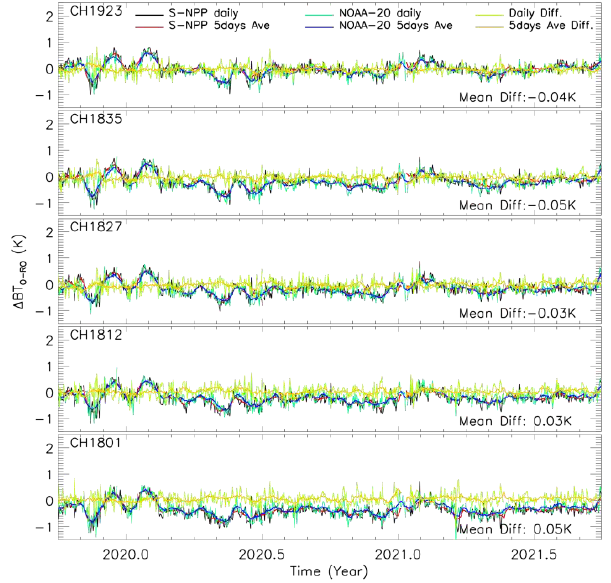
Figure 11. Same as Figure 9, except for results from the nighttime. The BT difference is much closer to zero at nighttime, and no annual cycle pattern is shown. Due to lower observed BT temperatures and increased instrument noise at night, the day-to-day BT difference variation became larger than that from daytime, especially in the first few months of the COSMIC-2 mission. The CRTM simulations in the five se- lected SWIR channels are also subject to the bias related to the fixed CO 2 amount in the simulation when using COSMIC-2 RO data products as inputs. After adjusting the ~0.3 K positive bias due to the increasing CO 2 amount in the real atmosphere, the BT differences for channels 1801, 1812, and 1827 could be closer to zero. Due to the larger day-to-day variation, it is more difficult to derive the CO 2 trend using SWIR channels than from the LWIR channels (see Figure 7). The inter-satellite differences between NOAA-20 and S- NPP are also included in Figures 9 – 11. Compared to LWIR channels, except for the highest WFPH channel 1923 (with – 0.05 K, compared to the LWIR channel 32 with 0.05 K), the mean double differences are much closer to zero, with − 0.06 K for channel 1835, − 0.05 K for channel 1827, 0.01 K for channel 1812, and 0.03 K for channel 1801. The inter-satellite differences are slightly dependent on the diurnal cycle, with smaller values in the day- time. The maximum difference between nighttime and daytime is 0.04 K on channel 1812. Other channels are less than 0.03 K.